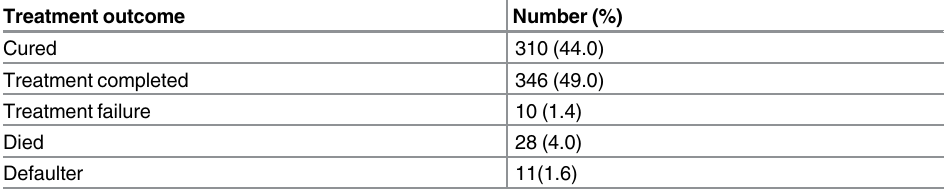
Table 5. Treatment outcomes of the study participants, West Gojjam Zone,